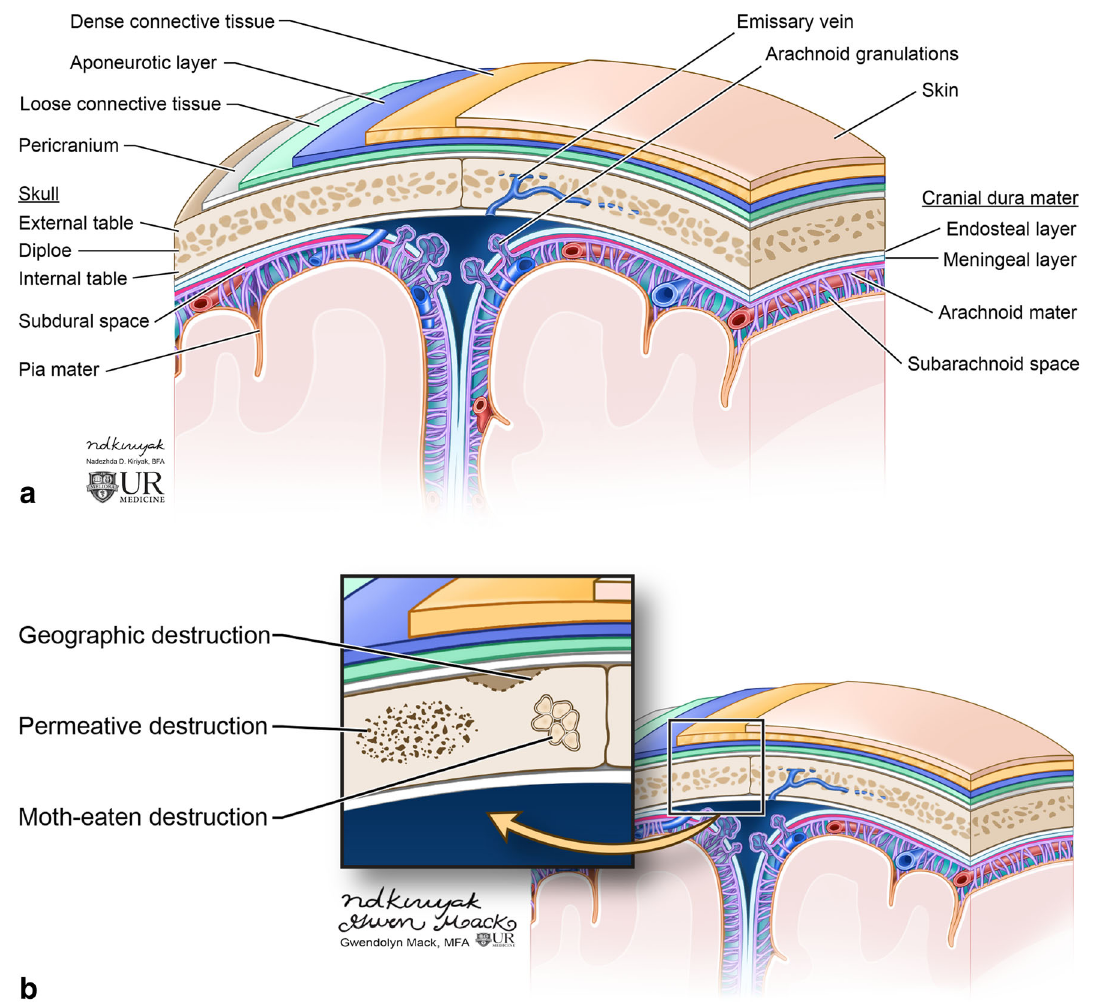
Fig.1 Imagedepicting thecalvarium anatomy ( a ). Theskull iscomposed of the marrow space (diploe), inner and outer tables. Covering the skull is the scalp which consists of the skin, subcutaneous dense connective tissue, galea aponeurotica and loose connective tissue. The outer table